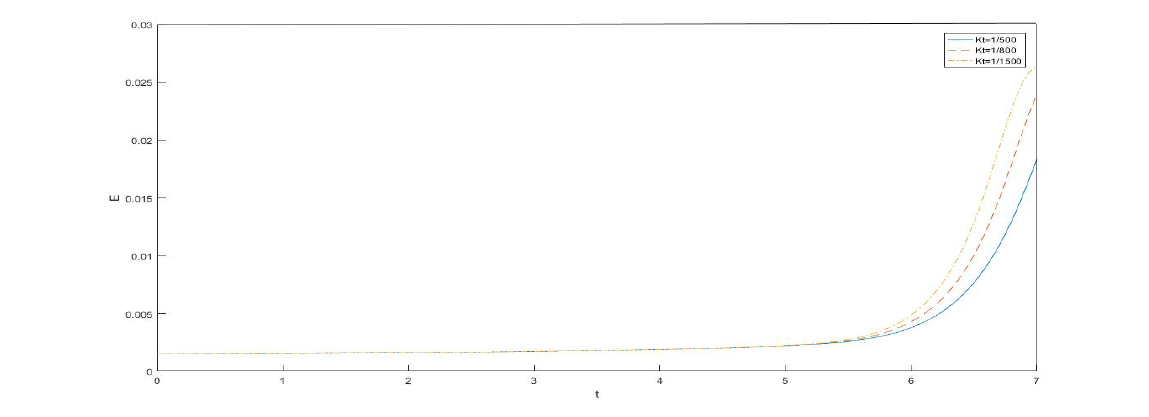
Fig. 5 The graph of the nonaxisymmetric portion ( E ) with m = 4 and α = 69 × 10 − 4